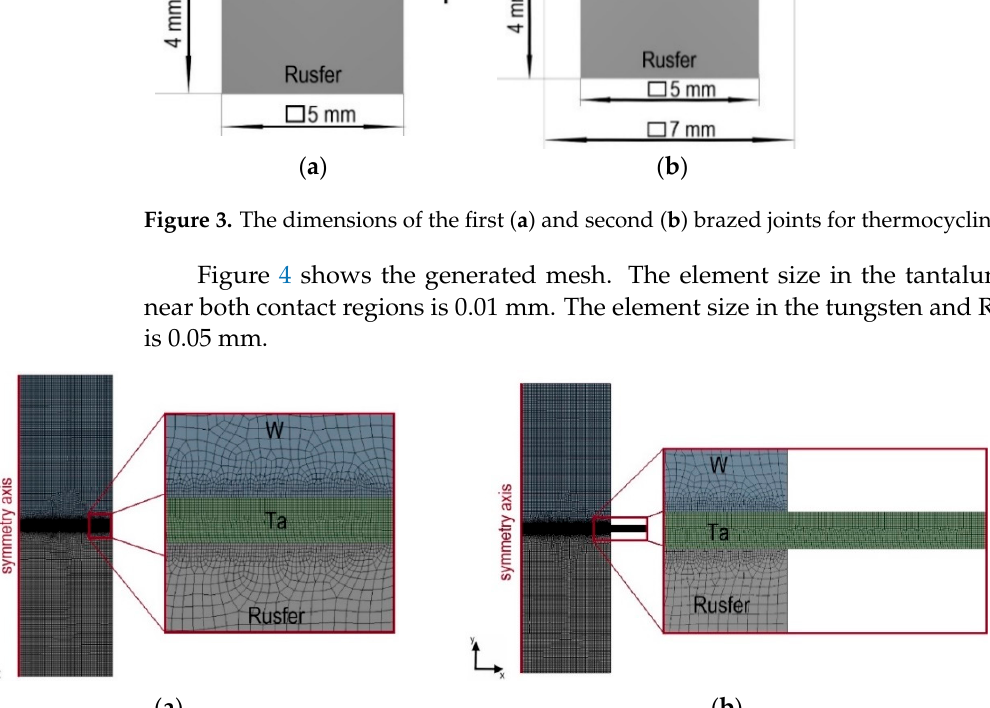
( b ) Figure 5. The boundary conditions for the first ( a ) and second ( b ) FEA models . 3. Results and Discussion 3.1. Microstructural Analysis Figure 6 shows the micrograph of the whole as-joined sample. We obtained the image in the area close to the fillet region of the sample. No cracks or pores were observed. Rusfer/Ta seam can be divided into the following zones: (1) martensite grains, (2) ferritic grains, (3) interaction zone with sharp phases, (4) interaction zone with elongated grains, (5) pure tantalum. Formation of the ferritic zone was also observed in [15,27,45]. The thick- ness of the layer increases closer to the fillet, because in Figure 6, a 50 μ m ferritic layer formed, but in the central zone of a sample [27], this was 20 μ m. In this work (Section 3.2), we present optical images of the central area of the joint, and the thickness is also close to 20–30 μ m in different samples. This means that the ferritic layer is thinner while brazing with TiZr4Be compared with Cu-based brazing alloys, where the scientists observed 200 μ m [11] and ≈ 300 μ m [46]. We divided the Ta/W seam into the following zones: (1) pure tantalum, (2) mechanical mixture, (3) thick dark layer, (4) pure tungsten. A thin grain boundary depletion of pure W is observed close to the Ta/TiZr4Be/W brazed seam, marked with an arrow in Figure 6.